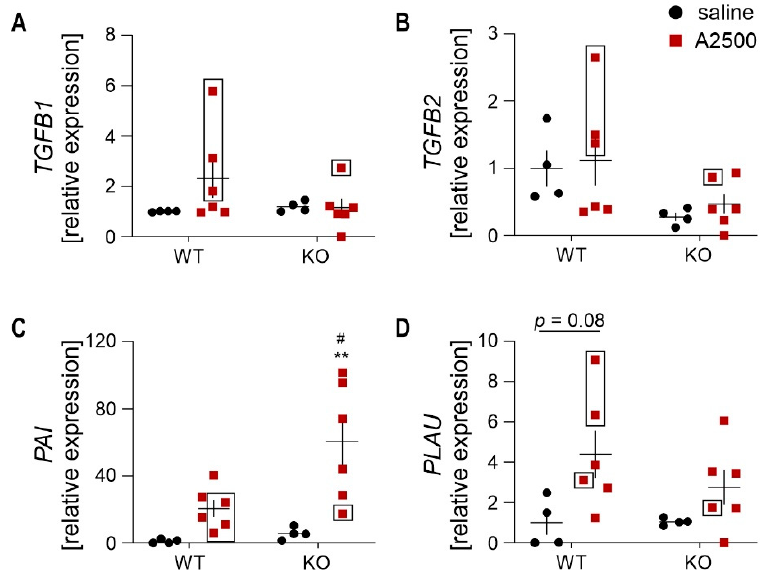
Figure 9. TGF β -dependent signaling upon AngII. ( A–D ) Relative expression of ( A ) TGFB1 ( B ) TGFB2 ; ( C ) PAI1 ; and ( D ) PLAU in the abdominal aortic wall at day 14 after placement of osmotic pumps. eEF2 was used as a reference gene. Two-way ANOVA with Tukey’s post hoc test; ** p < 0.01 vs. saline, # p < 0.05 vs. WT. Rectangle—mice which developed the aneurysm.